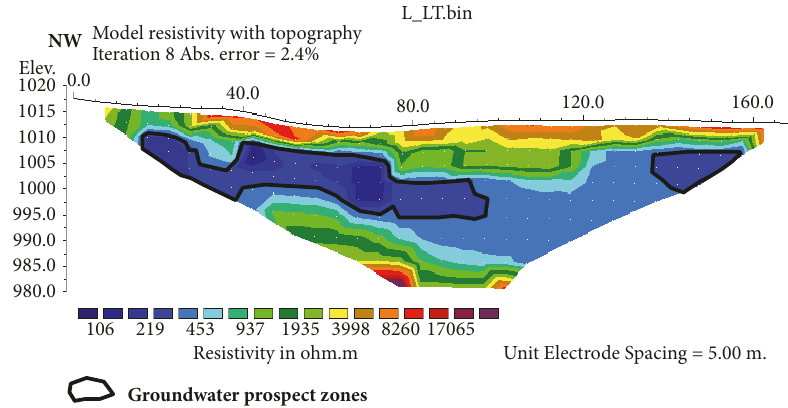
Figure 11: Inverse resistivity model along profile 8.